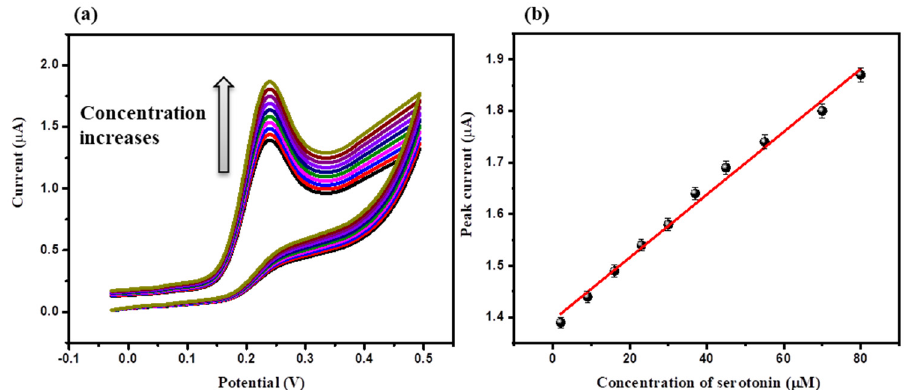
Figure 5. CVs ( a ) of MGCE in various concentrations (2 µ M, 9 µ M, 16 µ M, 23 µ M, 30 µ M, 37 µ M, 45 µ M, 55 µ M, 70 µ M, and 80 µ M) of serotonin in 0.1 M PBS (pH = 7.0) at fixed scan rate of 50 mV/s. Calibration curve ( b ) between peak current response versus concentration of serotonin.